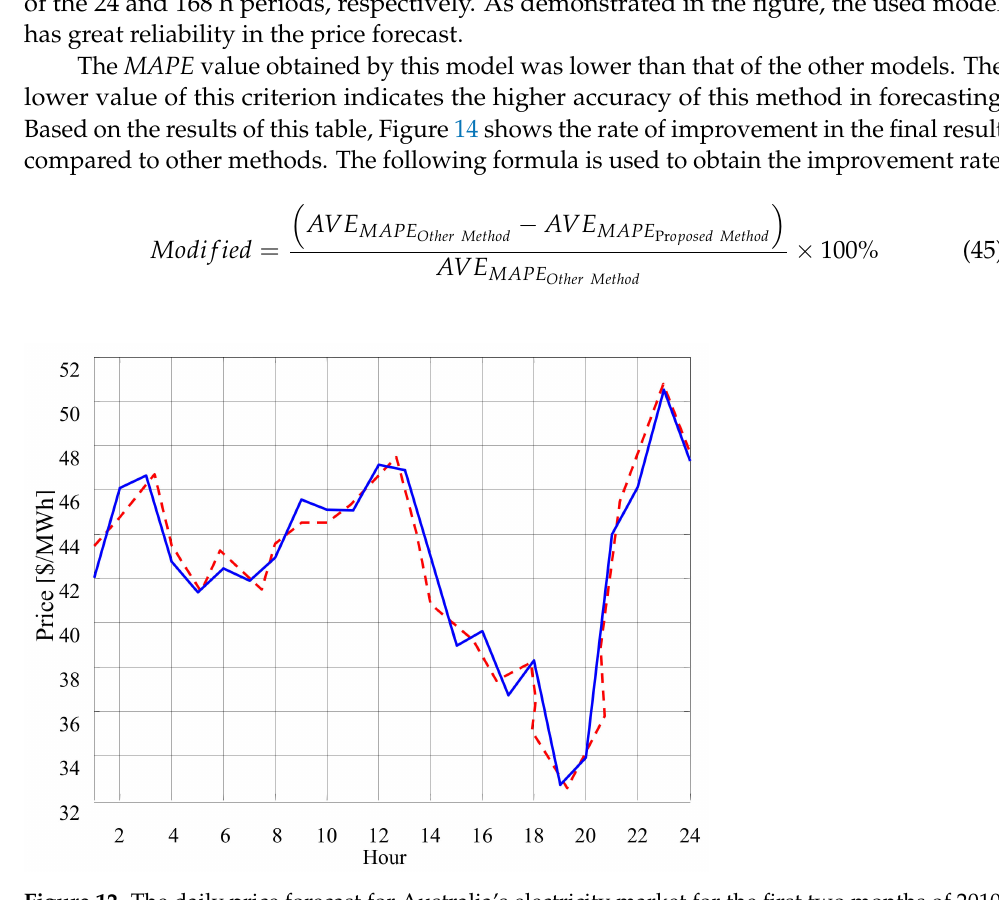
Figure 12. The daily price forecast for Australia’s electricity market for the first two months of 2010; the continuous blue line (the real price) and the dotted red line (the forecast